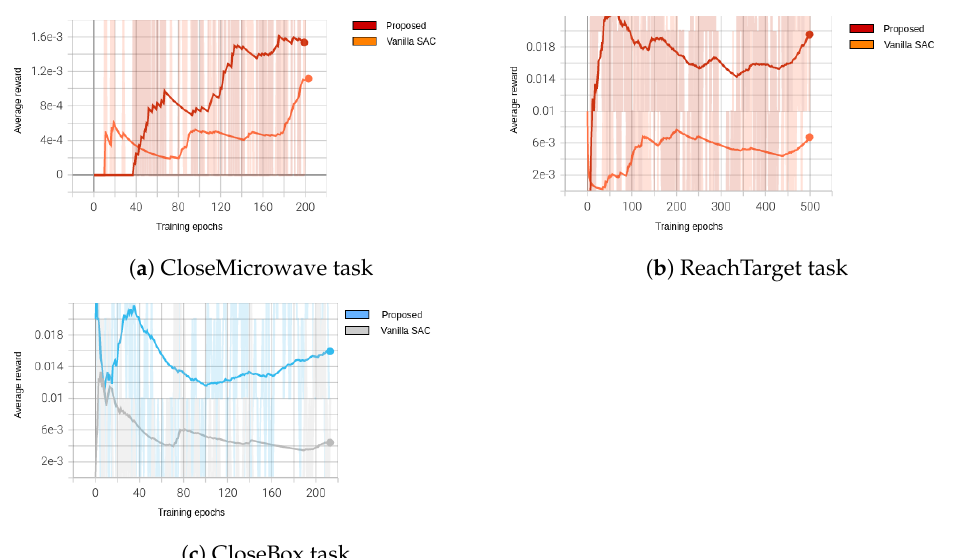
Figure 4. Comparison average reward results of the proposed method versus vanilla SAC. Red and blue lines are the results of the proposed method, and orange and gray lines are the results of vanilla